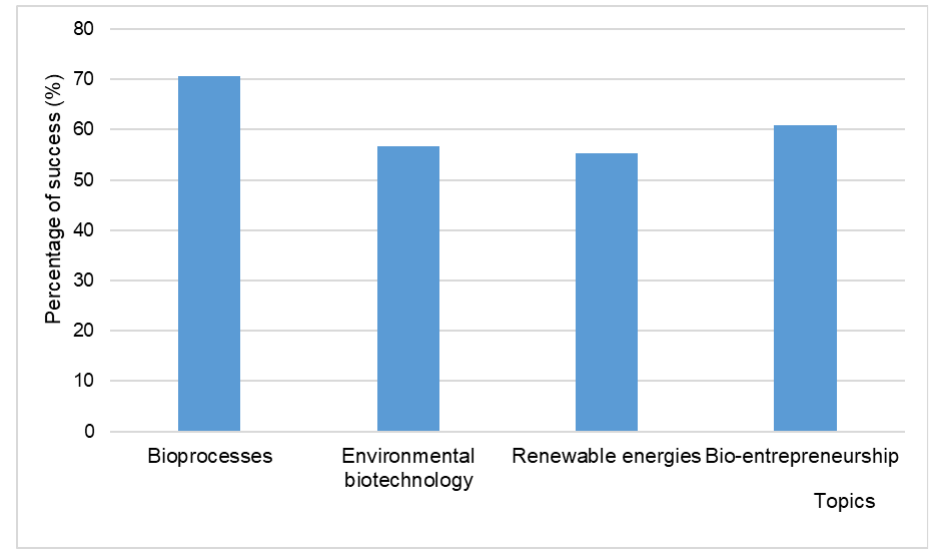
Figure 7. Percentage of success in the diagnostic test for the four main evaluated topics.